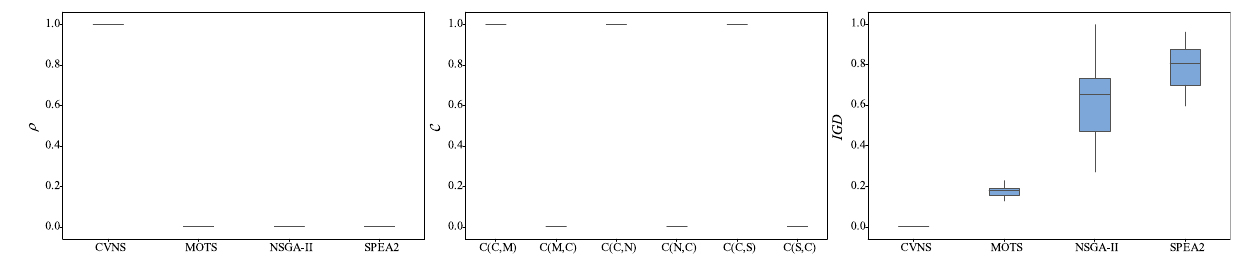
Figure 8. The box plots of three metrics for instances with 5 factories.